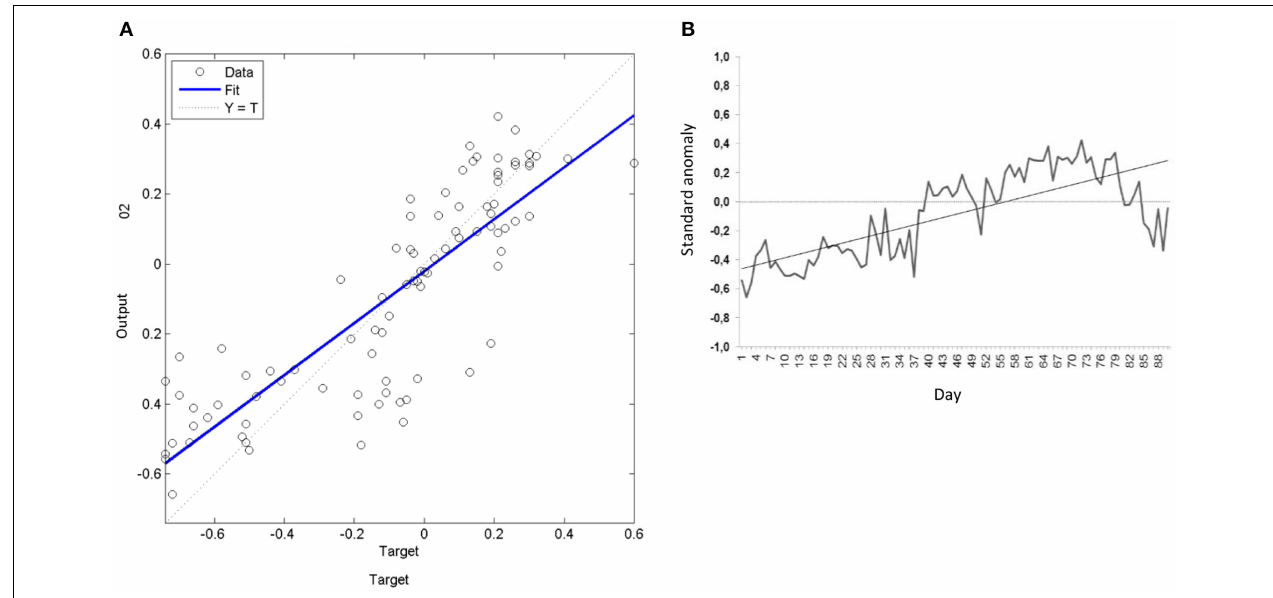
FIGURE 13 | Results of the future climate change scenario simulation during FMA season of the 2055–2095 period of the ANN model: (A) Cross-validation result from the best fit with MSE = 0.02 and corr = 0.84. The output simulated using as target the simulated daily precipitation